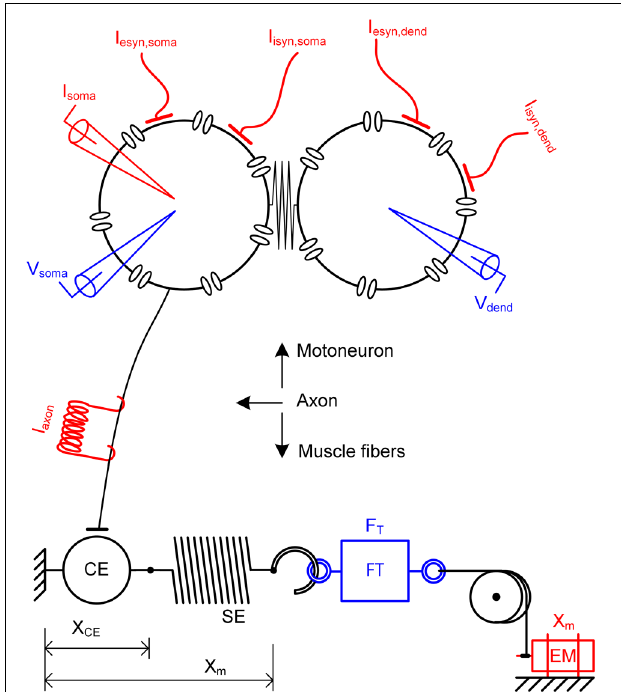
FIGURE 1 | Schematic diagram of a model motor unit system. Reduced motoneuron model consisting of somatic and dendritic compartments with coupling conductance (upper) , axon model for the perfect transmission of neural signals from the motoneuron (middle) and muscle-tendon model consisting of a contractile element (CE) and serial elastic element (SE) in series (bottom) . Input signals (red) to the motor unit model include the intracellular current injection at the soma (I soma ), excitatory and inhibitory synaptic inputs at the soma (I esyn , soma and I isyn , soma ) and the dendrite (I esyn , dend and I isyn , dend ), current impulse stimulation over the axon (I axon ) and length variation at the muscle (X m ). Output signals (blue) from the motor unit model include the membrane voltage at the soma (V soma ) and the dendrites (V dend ) and force at the muscle (F T ). X CE , FT and EM indicate the length of the contractile element, force transducer and electrical motor,